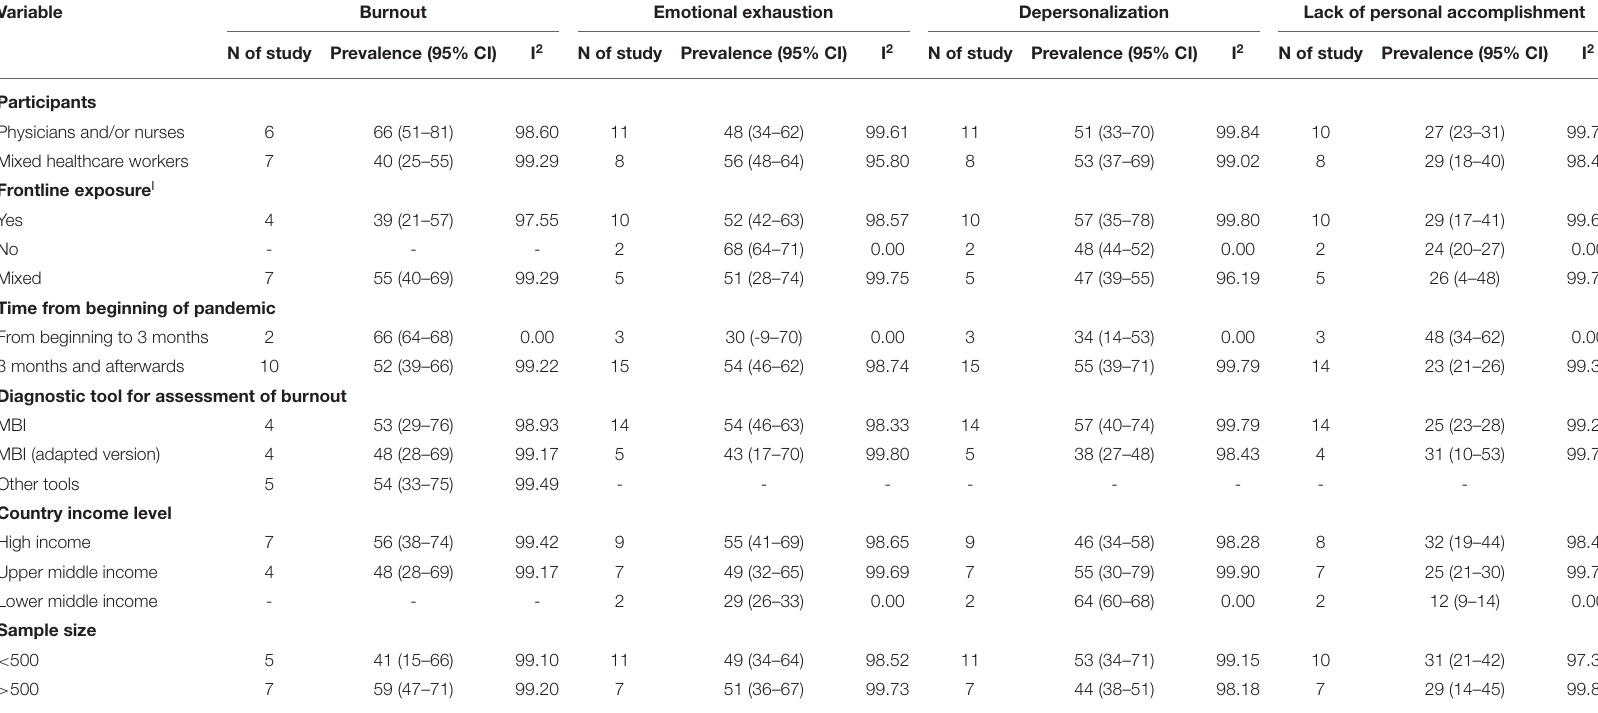
TABLE 2 | The results of the subgroup analysis for burnout and its three